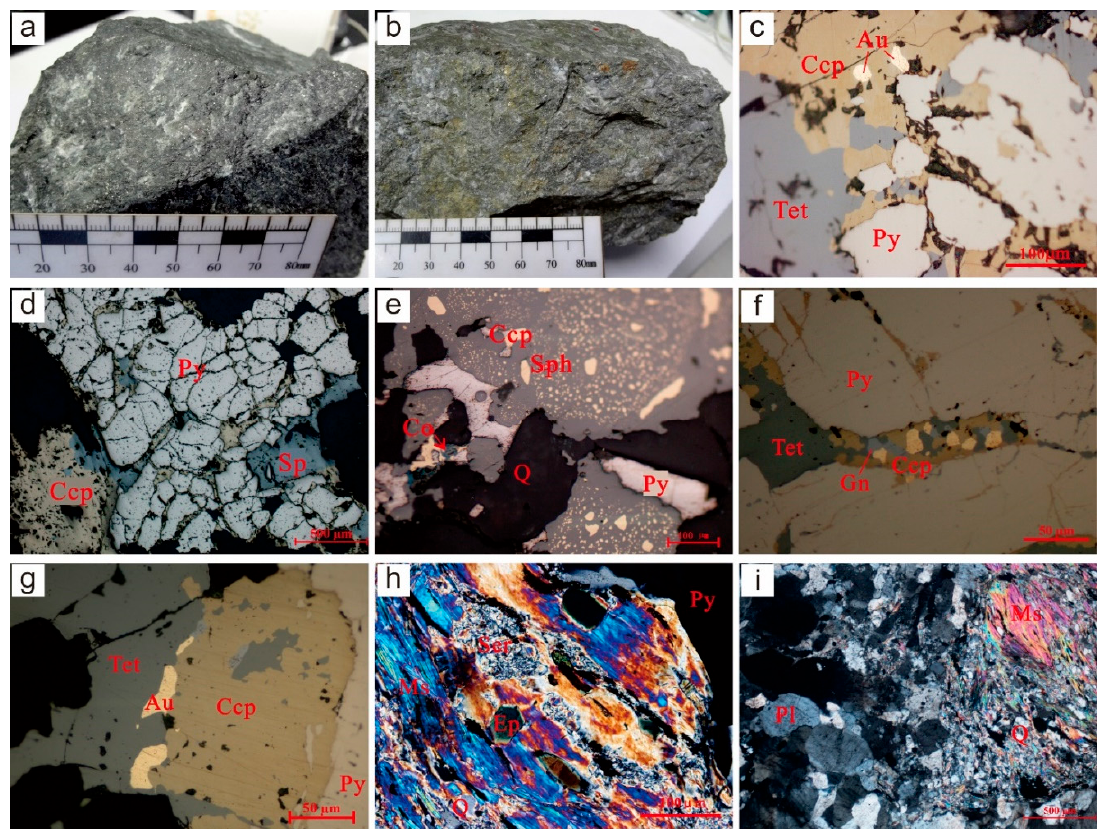
Figure 4. The mineral composition of ore: ( a ) quartz–sericite type ore; ( b ) altered amphibolic type ore; ( c ) gold occurs in chalcopyrite; ( d ) cataclastic texture of pyrite; ( e ) emulsion texture: chalcopyrite is distributed in sphalerite as tiny milk drops; ( f ) galena is symbiotic with chalcopyrite; ( g ) tetrahedrite is symbiotic with chalcopyrite, and gold is distributed in tetrahedrite in irregular granular or veined form; ( h and i ) parallel extinction of muscovite.